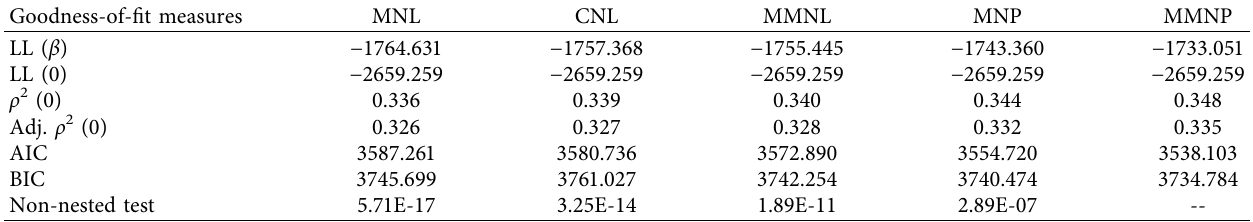
Table 7: Measures of model